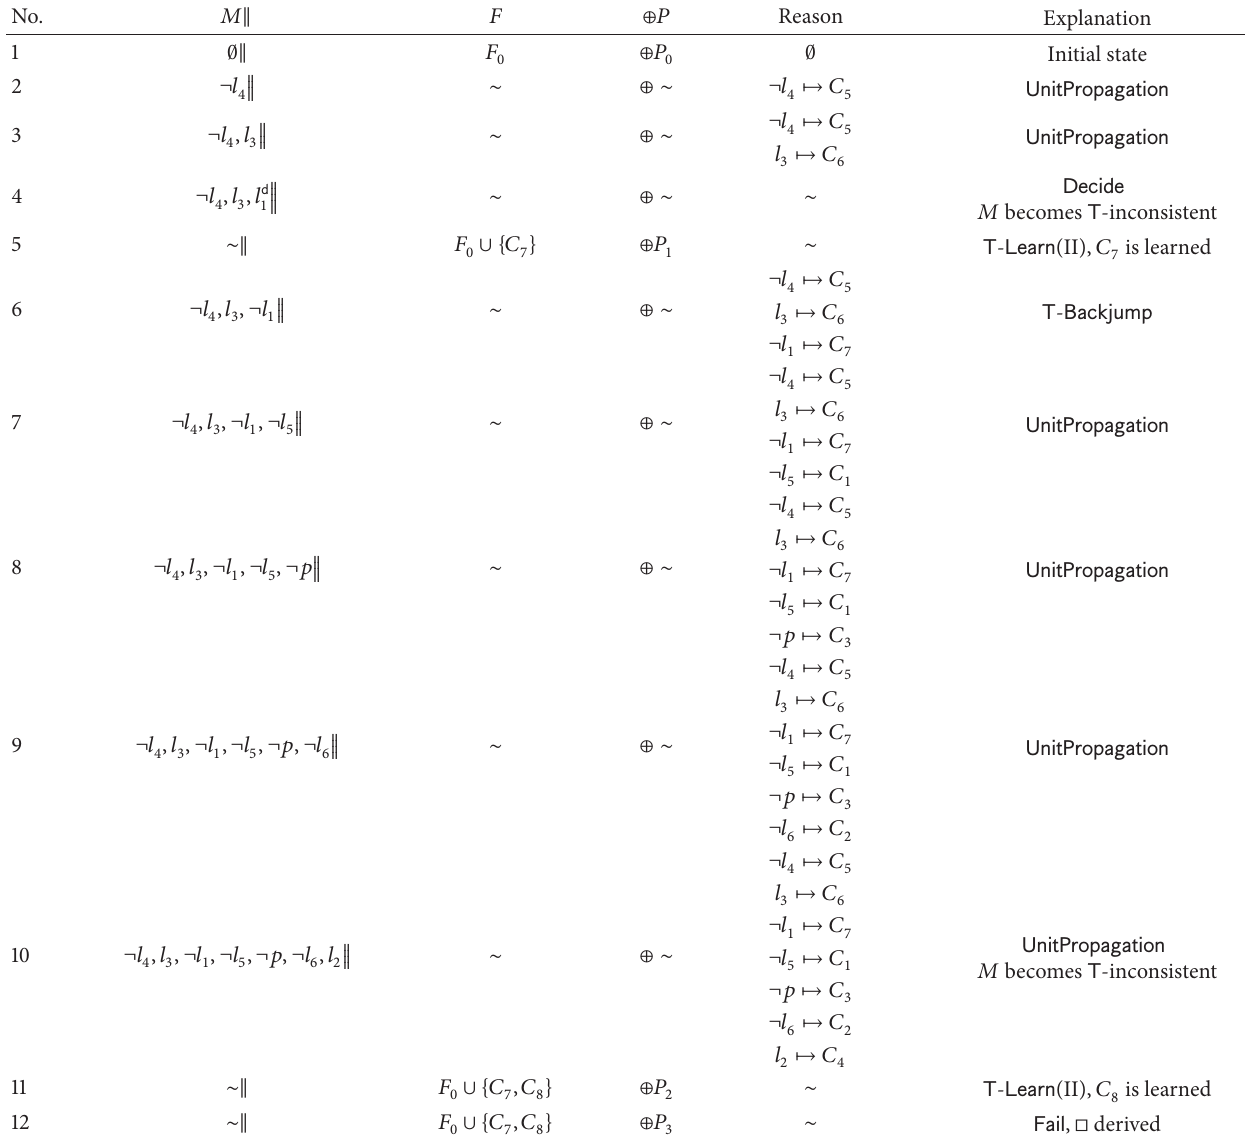
Table 3: A possible CDPLL( T )